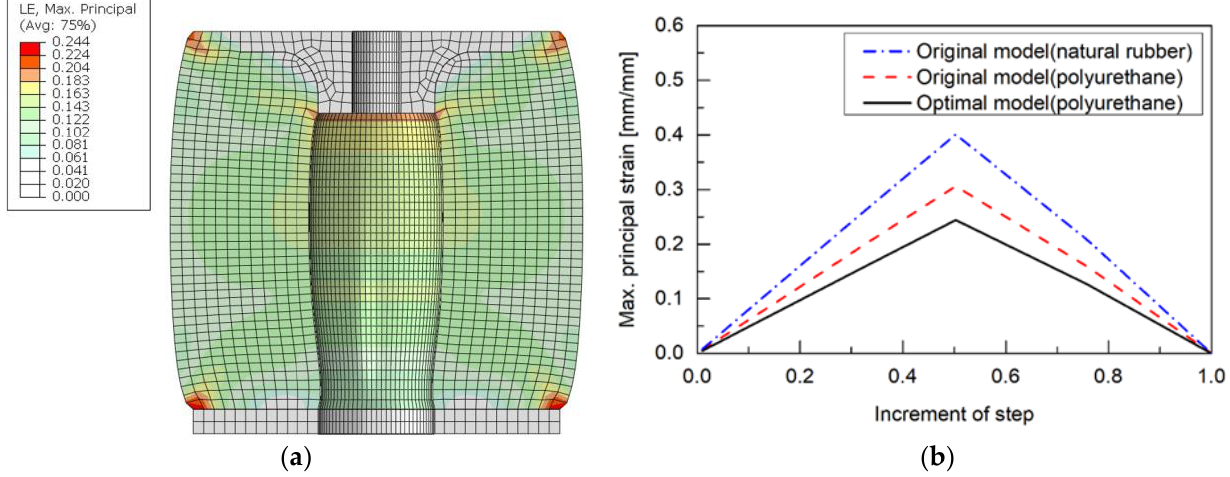
Figure 13. Optimization histories using MIGA: ( a ) optimization history; ( b ) detailed view of opti- mization history.